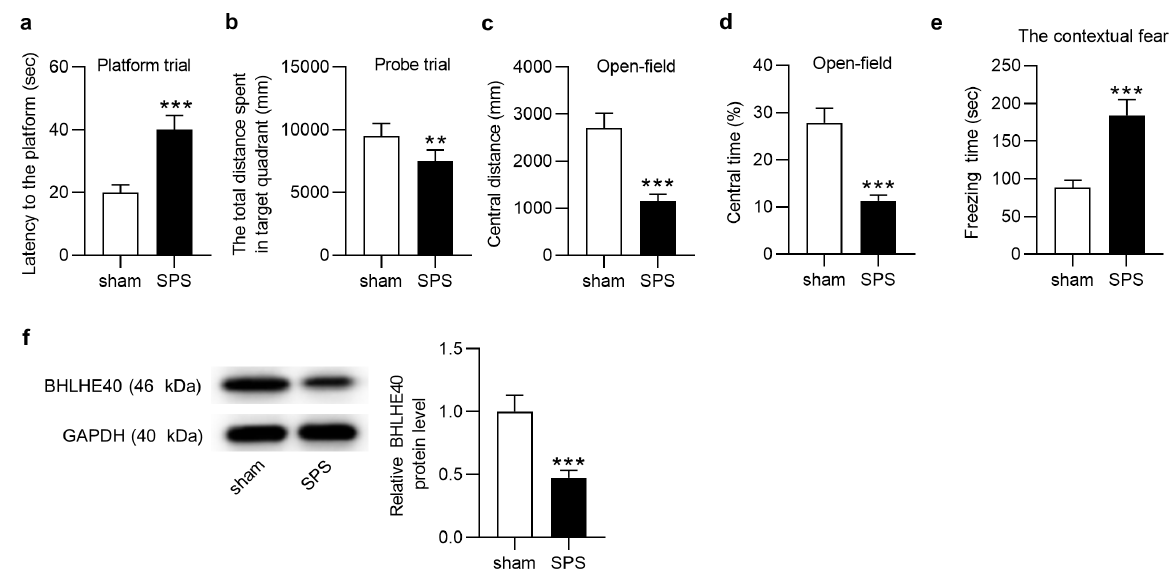
Figure 2. Successful establishment of SPS model mice and the downregulation of BHLHE40 protein levels in hippocampal tissues of SPS mice. (a) The escape latency that the mice (n=9/group) of the sham/SPS group spent in the visible platform trial on day 10. This experiment was conducted 3 times. (b) Total distance that the mice (n=9/group) of the sham/SPS group spent in target quadrant in the probe trial on day 10. This experiment was conducted once. (c-d) The distance and time that sham and SPS mice (n=9/group) spent in the central area in open field test on day 9. This experiment was conducted once. (e) Fear conditioning test of contextual fear memory assessment in sham and SPS groups (n=9/group) on day 11. This experiment was conducted once. (f) The protein levels of BHLHE40 in hippocampal tissues of SPS or sham mice (n=9/group) were determined by western blot. This experiment was conducted 3 times. Student’s t test was applied for data analysis in Figure 2. ** p < 0.01, *** p <